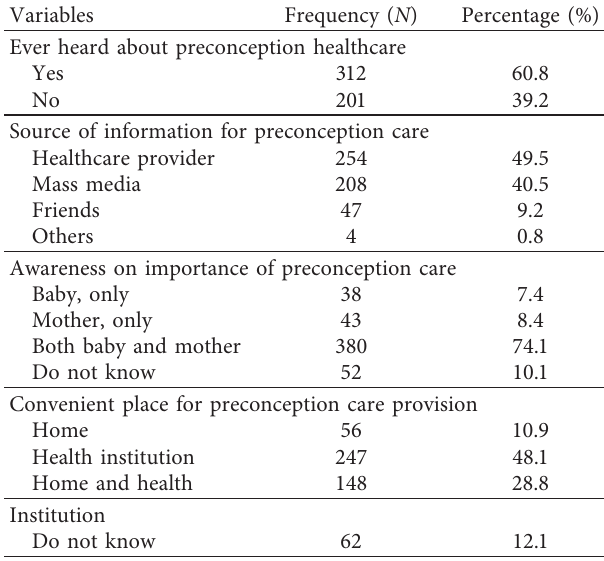
Table 2: Women’s awareness of preconception healthcare in Jinka town, Southern Ethiopia, 2018 ( n �